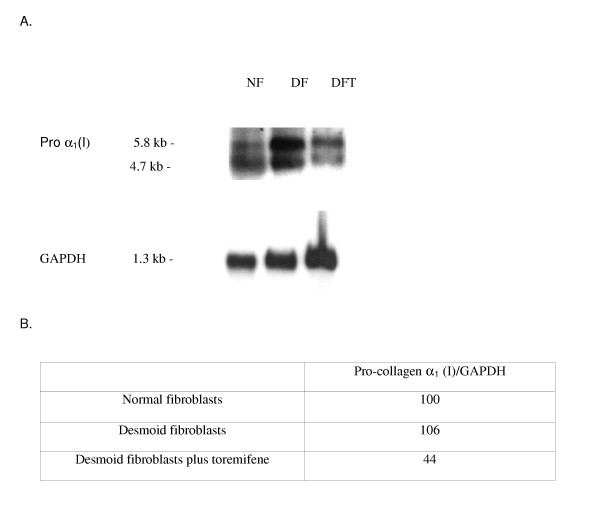
Expression of procollagen α1 (I) and glyceraldehydes-3-phosphate dehydrogenase (GAPDH) mRNA in normal and desmoid fibroblasts. Panel A: NF: normal fibroblasts; DF: desmoid fibroblasts; DFT: desmoid fibroblasts plus toremifene. Similar results were obtained in four separate experiments. In panel B the absolute counts, obtained by densitometric analysis, were converted to percentages of control value, assuming the untreated level of normal fibroblasts as 100%.